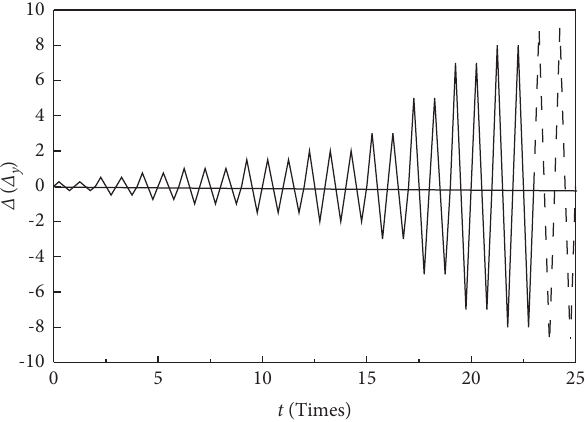
Figure 4: Loading system of C-CF-CFRP-ST